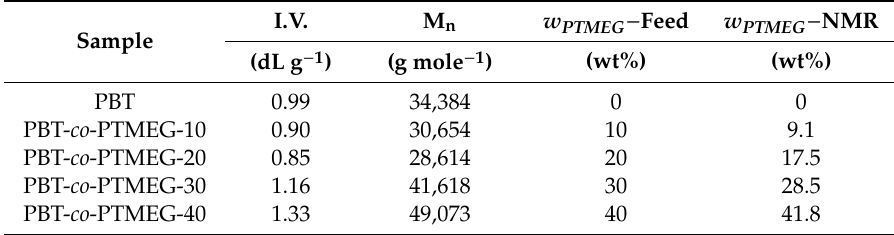
Figure 1. 1 H NMR spectrum of poly(butylene terephthalate- co -polypropylene glycol) (PBT- co - 1 H NMR spectrum of poly(butylene terephthalate- co -polypropylene glycol) PTMEG)-10 copolymer. (PBT- co -PTMEG)-10 copolymer. Table 1. Characteristic data of PBT and PBT- co -PTMEG Table 1. Characteristic data of PBT and PBT- co -PTMEG copolymers.